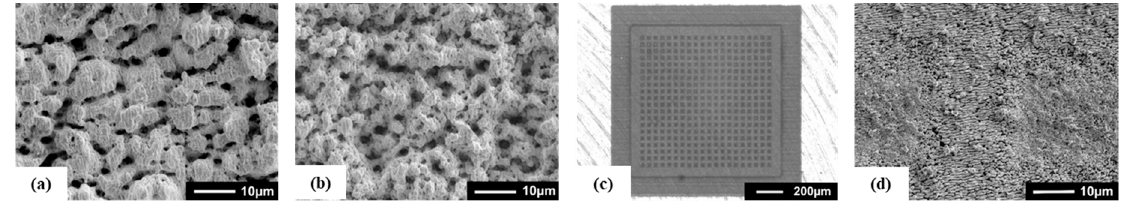
Figure 13. ( a ) SEM image of sintered samples, operated at max intensity = 6.74 × 10 12 W/cm 2 , energy per unit length = 0.7 J/m, scanning speed = 1250 m m/s, line spacing = 10 µm and pulse repetition rate = 125 kHz, 10 scans; ( b ) SEM image of sintered samples, operated at max intensity = 6.74 × 10 12 W/cm 2 , energy per unit length = 0.23 J/m, scanning speed = 3750 m m/s, line spacing = 10 µm and pulse repetition rate = 125 kHz, 10 scans; ( c ) optical image of sintered grid-like structures, operated at max intensity = 1.77 × 10 12 W/cm 2 , energy per unit length = 3 J/m, scanning speed = 600 m m/s, line spacing = 10 µm, and pulse repetition rate = 1 MHz, 6 scans; ( d ) SEM image of sintered grid-like structure sample (Adapted from reference [101]).